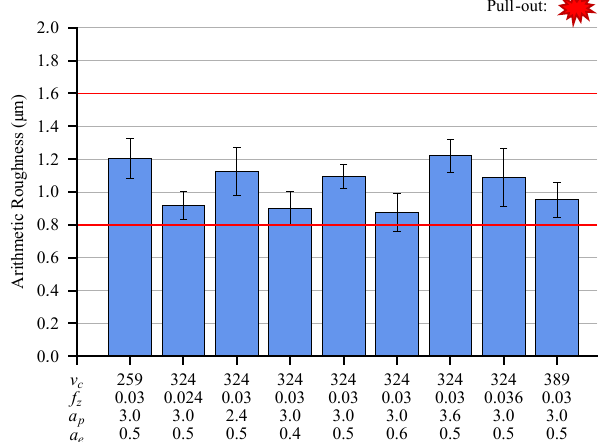
Figure 10. Qualification test of the composite tool, the evolution of Ra (µm) for different v c (m/min), f z (mm/tooth), a p (mm), and a e (mm). No material pull-out was observed.